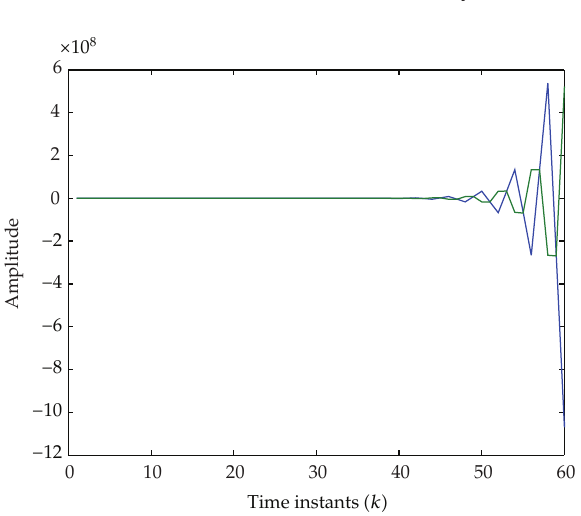
Figure 1: Trajectories of the system state in the simulation without the designed